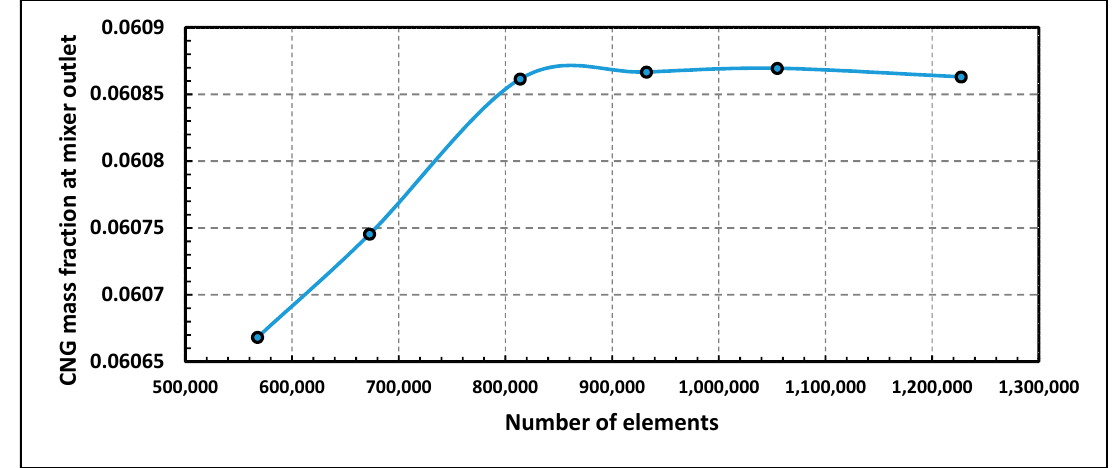
Figure 10. CNG mass fraction at mixer outlet (model 1), grid dependence test results.